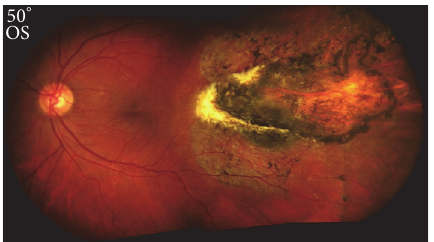
Figure 2: Color fundus photograph of the patient’s left eye demon- strating a comet-shaped temporal chorioretinal scar consistent with